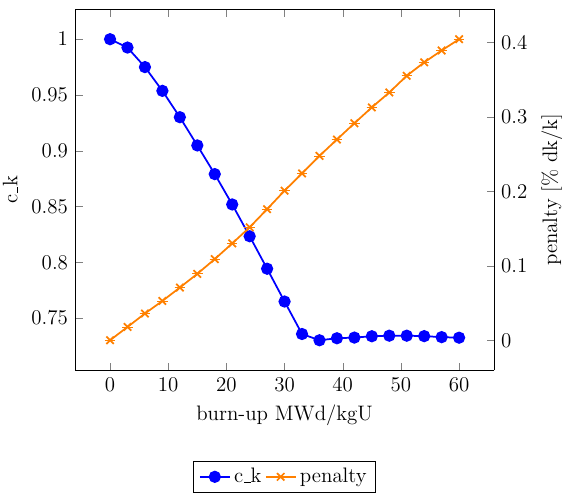
Figure 7. Comparison of irradiated fuel with fresh UO and MOX fuel experiments 2